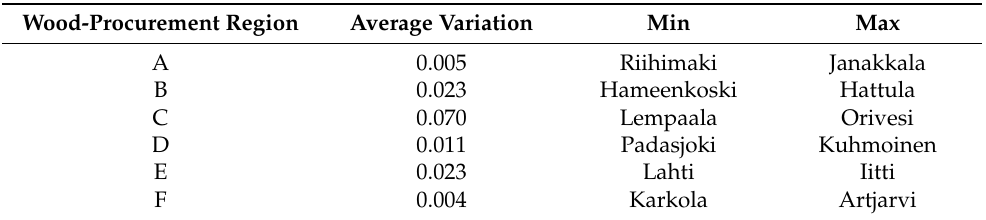
Table 4. Average variation (standard deviation) in the deliveries of municipalities in wood- procurement regions (A–F) in the changes in the production situations, as well as the least (Min) and most (Max) responsive municipalities.